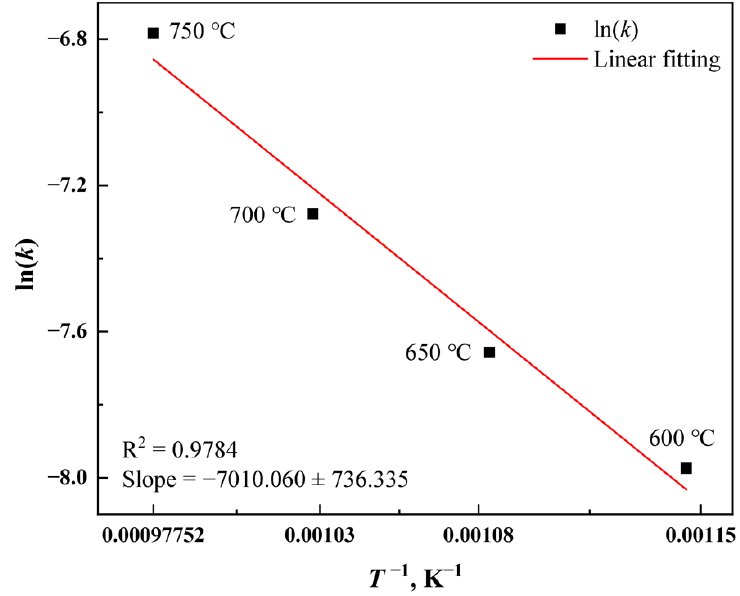
Figure 12. Arrhenius plot for decomposition rate of RE minerals.